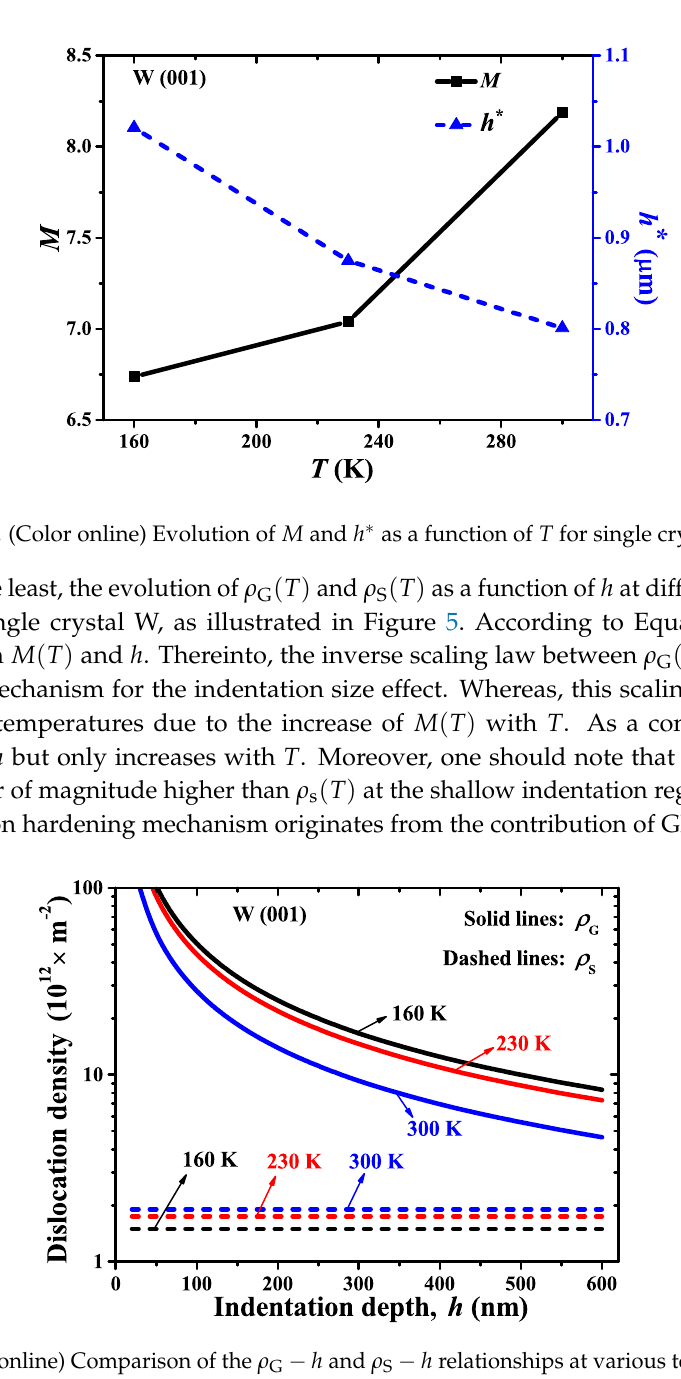
Figure 5. (Color online) Comparison of the ρ G − h and ρ S − h relationships at various temperatures for single crystal